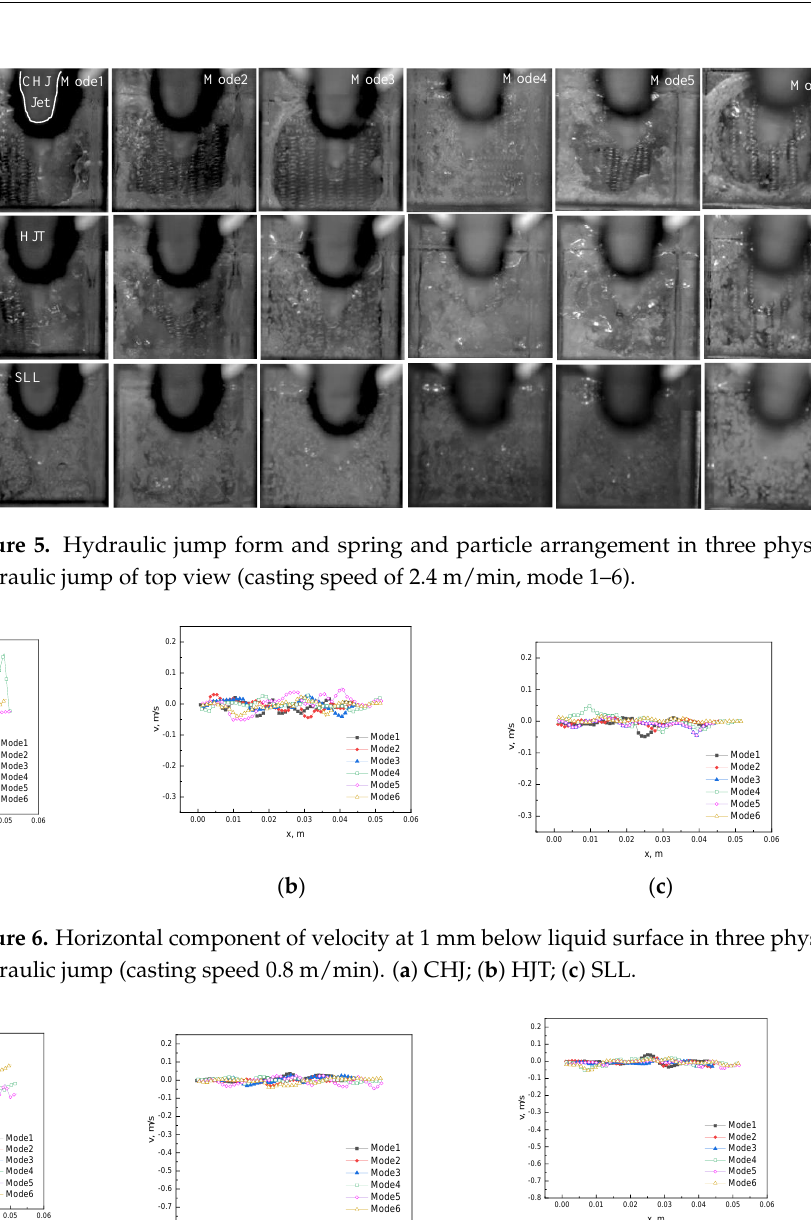
Figure 4. Hydraulic jump form and flow field in three physical forms of hydraulic jump of front view (casting speed of 2.4 m/min, mode 1 – 6).